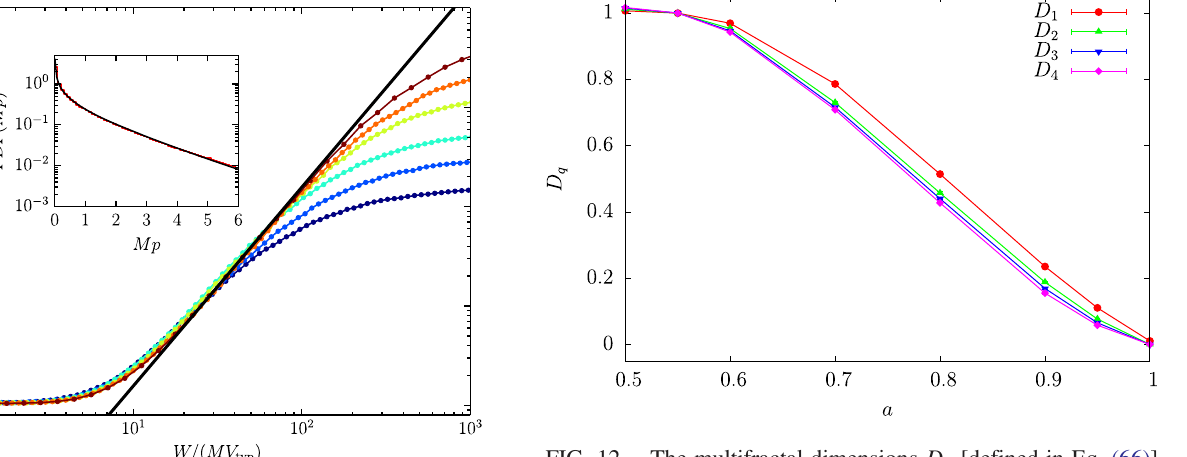
FIG. 12. The multifractal dimensions D 1 [defined in Eq. (66)] and D 2 [defined in Eq. (65)] as functions of γ for the ensemble FIG. 11. The rescaled inverse participation ratio I 2 M= 3 as a of IB Hamiltonians with the dispersion of classical energies function of the rescaled impurity band width W= ð MV for W ¼ λ V M γ = 2 , with λ ¼ 3 . 3 . All the multifractal dimensions D typ Þ typ different numbers M of states in the impurity band. We see that approach 1 in the ergodic regime ( γ ¼ 1 ) and 0 in the localized ≤ 1 , we have I 3 ¼ 1 , in the ergodic regime, W= ð MV 2 M= regime ( γ ¼ 2 ). The difference between D 1 and D 2 is also likely typ Þ corresponding to the orthogonal Porter-Thomas distribution of due to finite size effects. We also extract a scaling exponent from states in the impurity band. The inset shows the numerical the dynamical correlator [see Eqs. (68) and (69)]. The dot-dashed probability distribution of normalized probabilities Mp for an line corresponds to the analytical value in the Rosenzweig-Porter eigenstate over computational states z in the ergodic regime in limit given by Eq. (72). black and the analytical orthogonal Porter-Thomas distribution in red. Qualitative arguments in Sec. VIII suggest that in the 2 . The nonergodic delocalized regime I 2 M= 3 ∝ ½ W= ð MV typ Þ(cid:2) 2 , and we see that black line is proportional to ½ W= ð MV typ Þ(cid:2) I 2 M= 3 aligns with this quantity as long as we do not enter the ≥ 1 ; see Fig. 10. localized regime δϵ =V typ